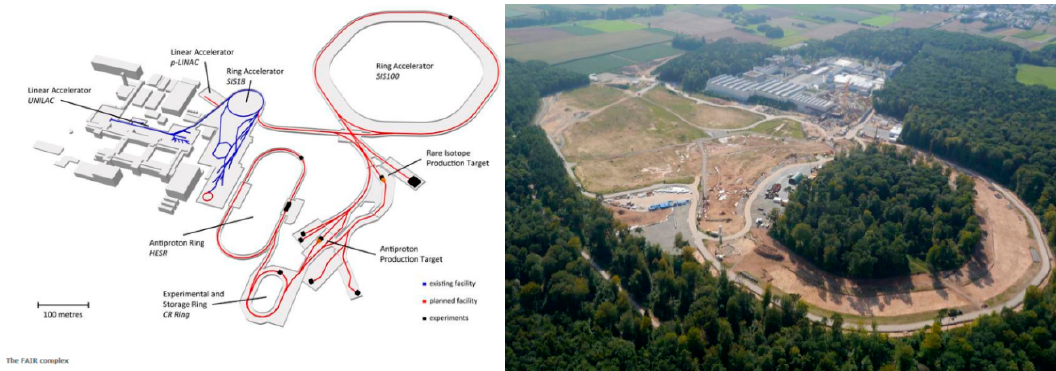
Figure 1. The layout of the Facility for Antiproton and Ion Research (FAIR; left ) and a bird’s eye view of the construction place ( right ).